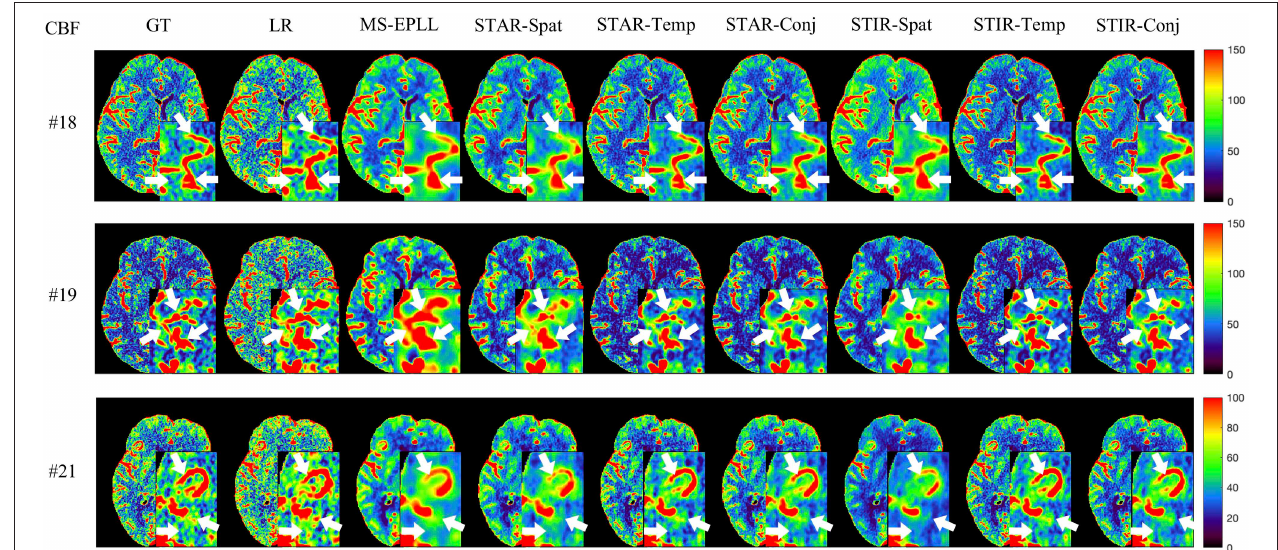
FIGURE 5 | Visual comparison of CBF for three test patients: #18, #19, and #21, when reducing the tube current to 40 mAs with a down-sample ratio of three (three times low spatial and two time low temporal resolutions). The notation for each column is: GT, Ground truth image; LR, Low-Resolution input; MS-EPLL, MS-EPLL restoration result; STAR-Spat, STAR reconstruction result (spatial only); STAR-Temp, STAR reconstruction result (temporal only); STAR-Conj, STAR reconstruction result (spatial + temporal); STIR-Spat, STIR-Net reconstruction result (spatial only); STIR-Temp, STIR-Net reconstruction result (temporal only); STIR-Conj, STIR-Net reconstruction result (spatial + temporal). All figures are displayed by using the same colormap and the color range for each patient is shown in the colorbar on the rightmost of each row. We use white arrows to compare the details in the region of interests.